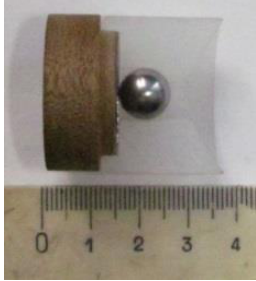
Fig 2. The type of steel spherical drummer in the master Al 2 O 3 , two-layer cermet materials No. 2 (TiB 2 + NiTi) + Ti [9], titanium alloy No. 3 VT1-0